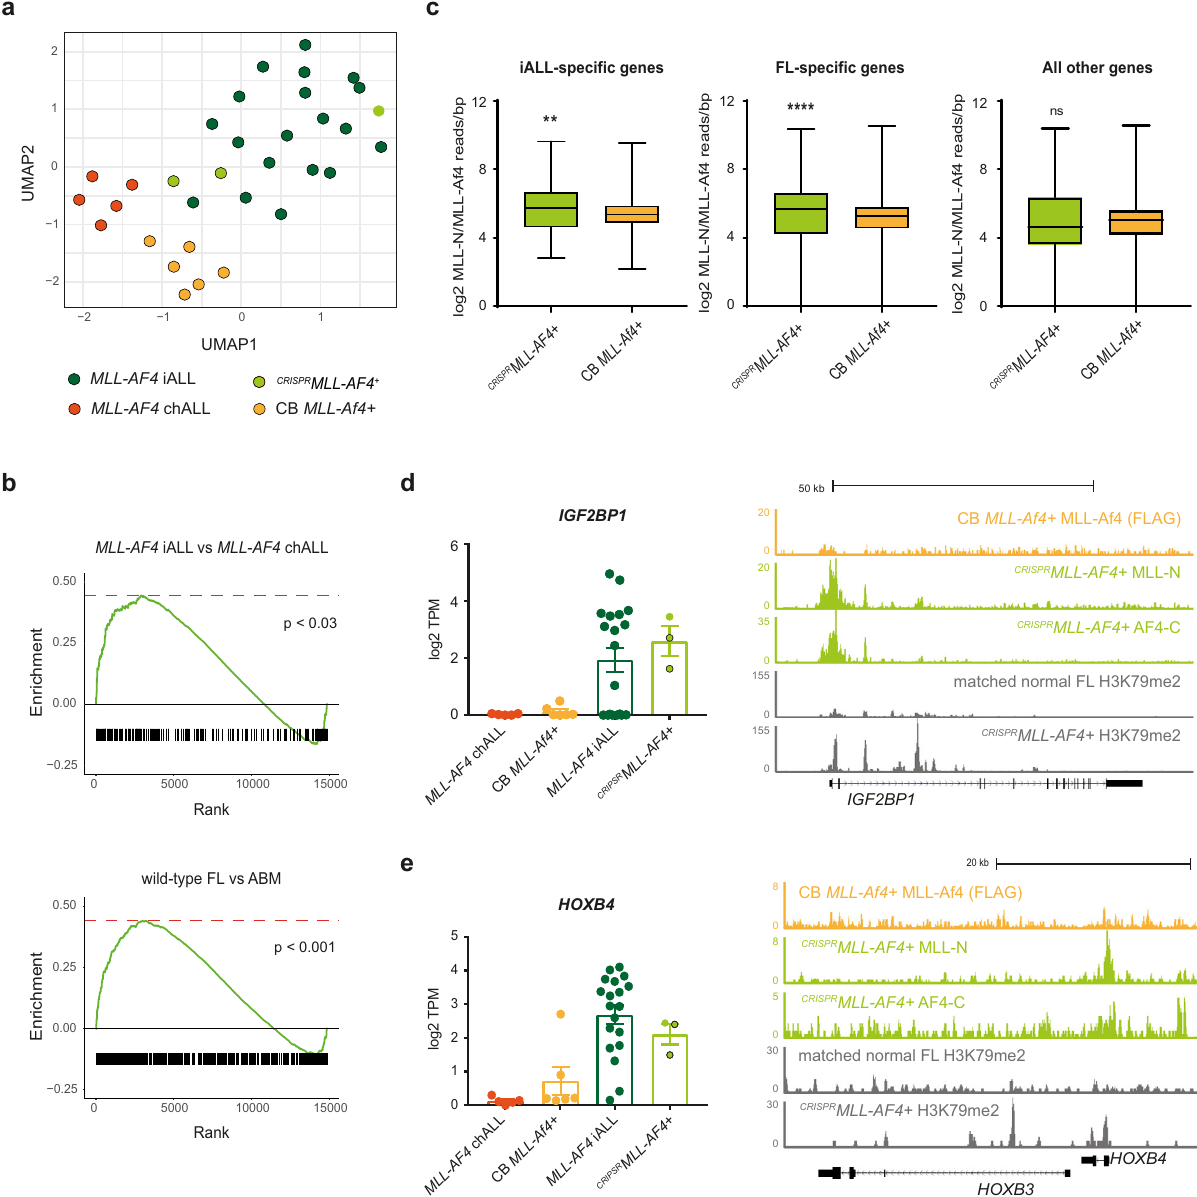
Fig. 5 FL-derived CRISPR MLL-AF4 + ALL speci fi cally recapitulates the molecular pro fi le of MLL-AF4 infant-ALL. a UMAP showing clustering of CRISPR MLL- AF4 + ALL (light green; black border = proB ALL, no border = preB ALL), MLL-AF4 infant-ALL (iALL (dark green), n = 19), MLL-AF4 childhood-ALL (chALL (orange), n = 5) 20 , and CB MLL-Af4 + ALL 35 (yellow, n = 6) based on a set of genes differentially expressed in both FL (compared to ABM) and MLL-AF4 infant-ALL (compared to MLL-AF4 childhood-ALL) (139 genes; Supplementary Data 2). b Gene set enrichment analyses (GSEA) 52 showing CRISPR MLL- AF4 + ALL is signi fi cantly more enriched for genes upregulated in MLL-AF4 infant-ALL (compared to MLL-AF4 childhood-ALL) (617 genes, p < 0.03) and in FL (compared to ABM) (5709 genes, p < 0.001) when compared to CB MLL-Af4 + ALL . c Box-and-whisker plots showing MLL-AF4 enrichment (MLL-N ChIP-seq reads/bp normalized to 10 7 total reads) for CRISPR MLL-AF4 + ALL and CB MLL-Af4 + ALL (FLAG ChIP-seq) at infant-ALL-speci fi c genes (193 genes, two-tailed Mann – Whitney test, p = 0.012) and FL-speci fi c genes (3949 genes, two-tailed Mann – Whitney test, p < 0.0001). Data are shown as mean ± SEM. Source data are provided as a Source Data fi le. d (left) Barplot showing expression of IGF2BP1 in MLL-AF4 childhood-ALL (chALL (orange), n = 5) 20 , CB MLL-Af4 + ALL (yellow, n = 6) 35 , MLL-AF4 infant-ALL (iALL (dark green), n = 19) 20 and CRISPR MLL-AF4 + ALL (light green; black border = proB ALL, no border = preB ALL). Data shown as mean ± SEM. Source data are provided as a Source Data fi le. (Right) MLL-Af4 (FLAG ChIP-seq) in CB MLL-Af4 + ALL, MLL-N, and AF4-C ChIP-seq in CRISPR MLL-AF4 + ALL and H3K79me2 ChIP-seq in CRISPR MLL-AF4 + ALL and matched unedited FL sample at IGF2BP1 . ChIP-seq data shown are normalized to 10 7 total reads. e (left) Barplot showing expression of HOXB4 in MLL-AF4 childhood-ALL (chALL (orange), n = 5) 20 , CB MLL-Af4 + ALL (yellow, n = 6) 35 , MLL-AF4 infant-ALL (iALL (dark green), n = 19) 20 , and CRISPR MLL-AF4 + ALL (light green; black border = proB ALL, no border = preB ALL). Data are shown as mean ± SEM. Source data are provided as a Source Data fi le. (Right) MLL-Af4 (FLAG ChIP- seq) in CB MLL-Af4 + ALL, MLL-N, and AF4-C ChIP-seq in CRISPR MLL-AF4 + ALL and H3K79me2 ChIP-seq in CRISPR MLL-AF4 + ALL and matched unedited FL sample at HOXB3/HOXB4 . ChIP-seq data shown are normalized to 10 7 total